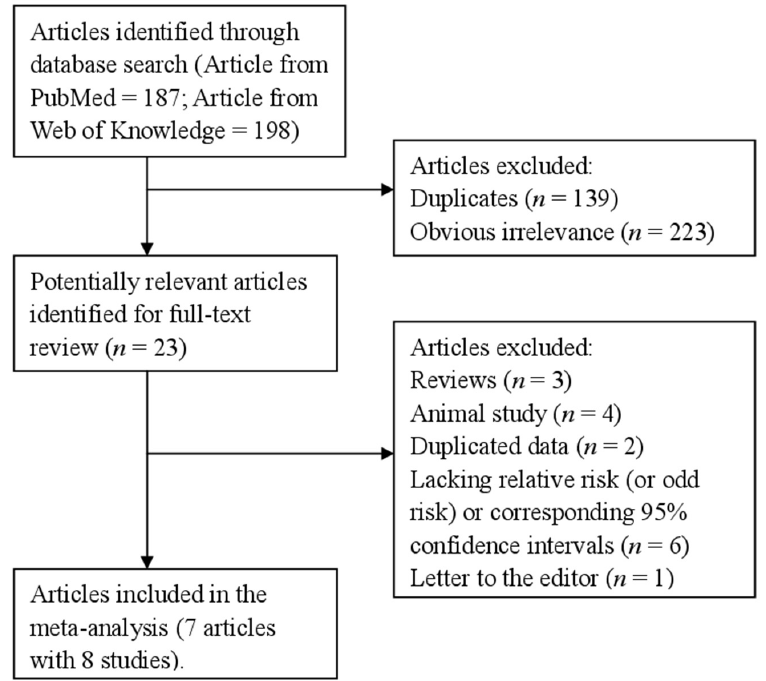
Figure 1. The detailed steps of our literature search.